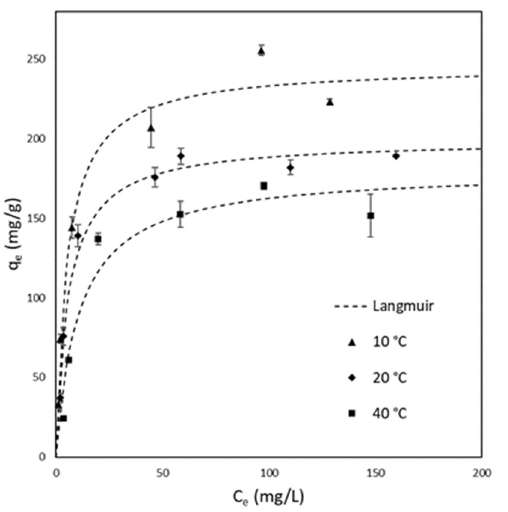
Figure 7. Isotherms of AV0 at 10 °C, 20 °C, and 40 °C fitted by the Langmuir model. Table 4. Langmuir isotherm parameters at 10 °C, 20 °C, and 40 °C for AV0. Parameter